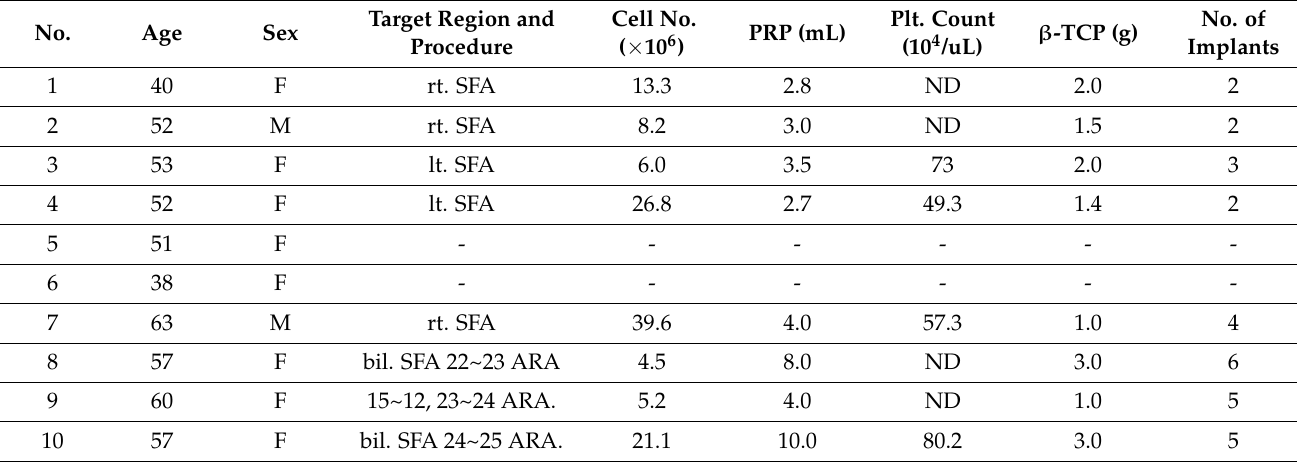
Table 1. Summary of patient information.